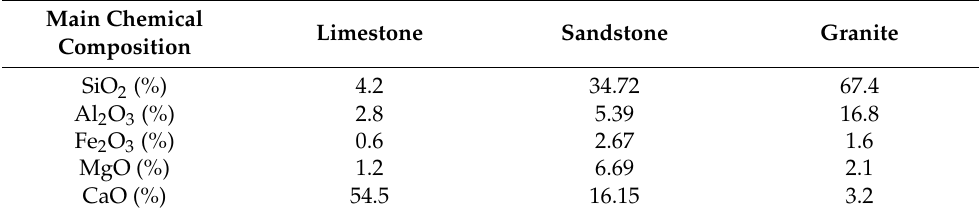
Table 3. Chemical compositions of aggregate.